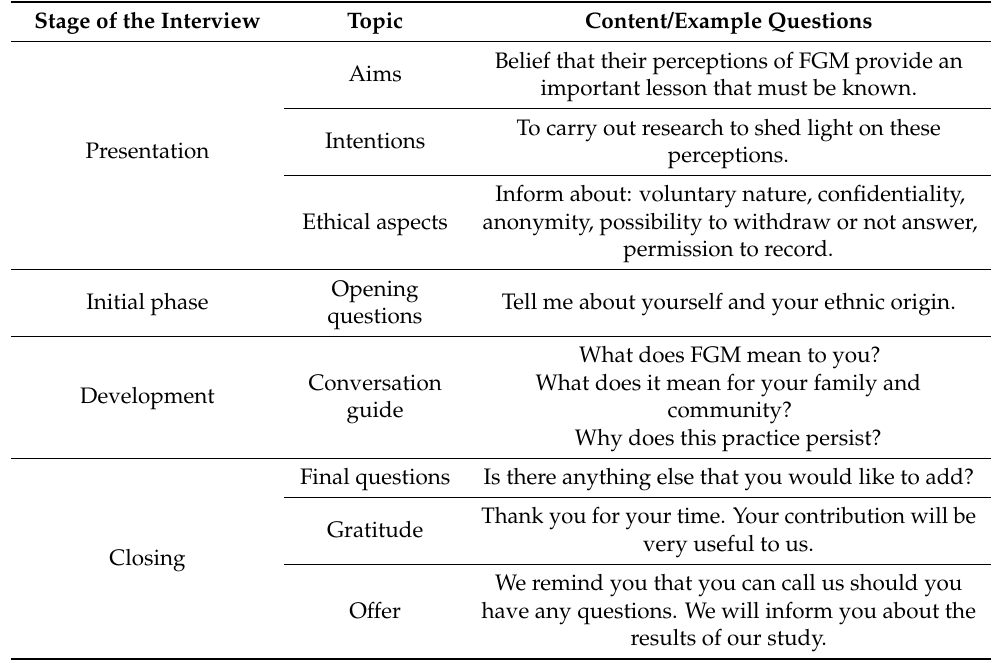
Table 2. Interview